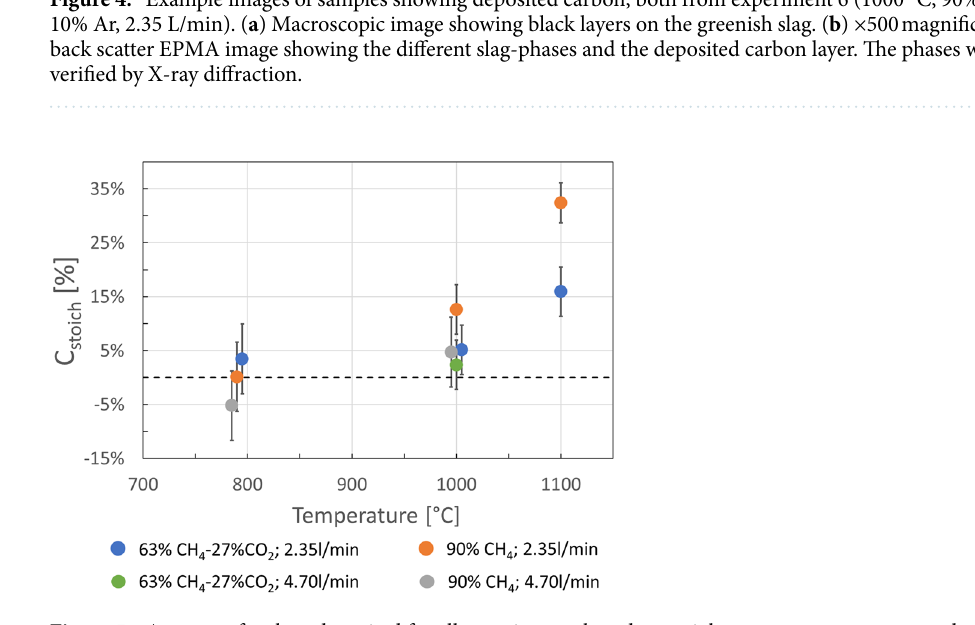
Figure 5. Amount of carbon deposited for all experiments, based on weight measurements, expressed as C stoich (see text). For repeat experiments, each data point represents an average of all experiments with identical experimental parameters. The data points at common temperatures have been spaced out along the x-axis to improve readability. All data points have been recorded at T = 790 °C, 1000 °C or 1100 °C,